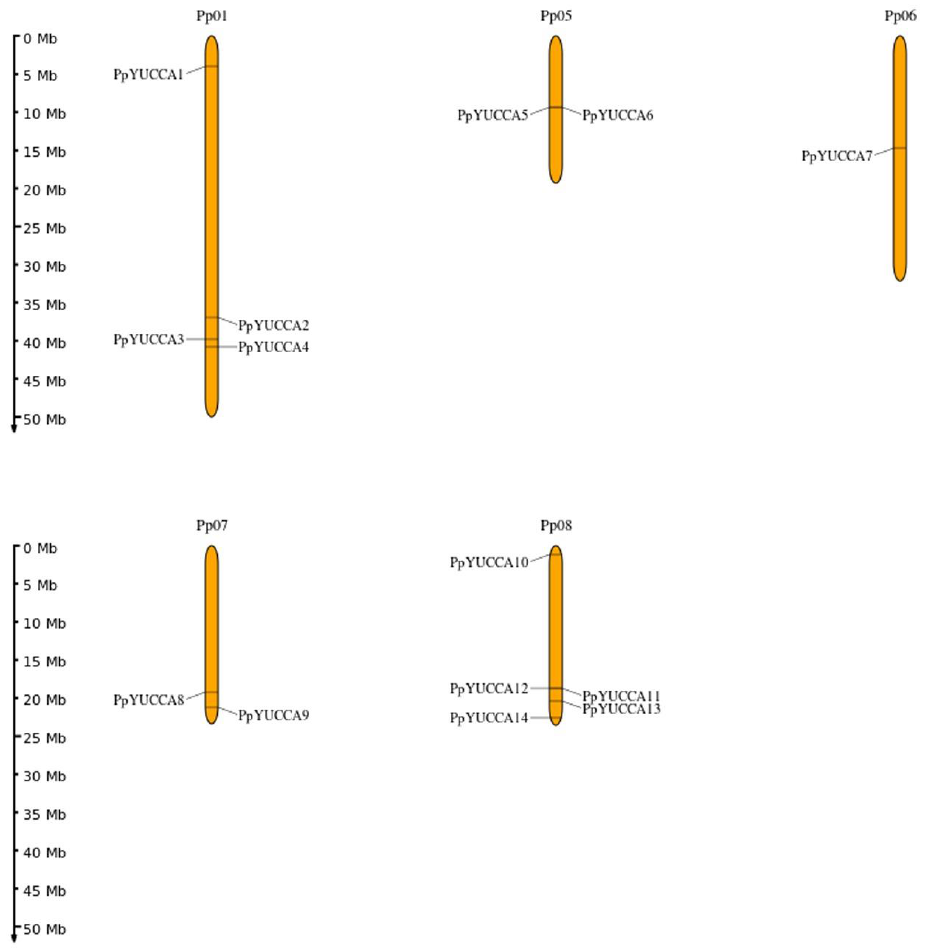
Figure 1. Chromosomal locations of Prunus persica var. pendula YUCCA genes. The scale represents a 50 Mb chromosomal distance.